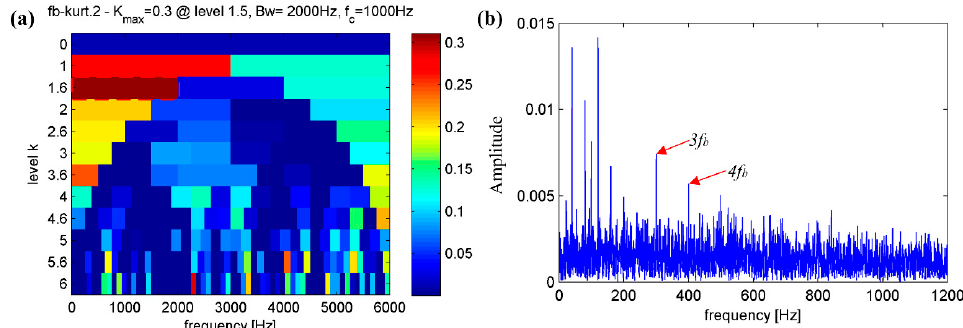
Figure 11. ( a ) Optimal resonance band obtained by Kurtogram; ( b ) envelope spectrum.